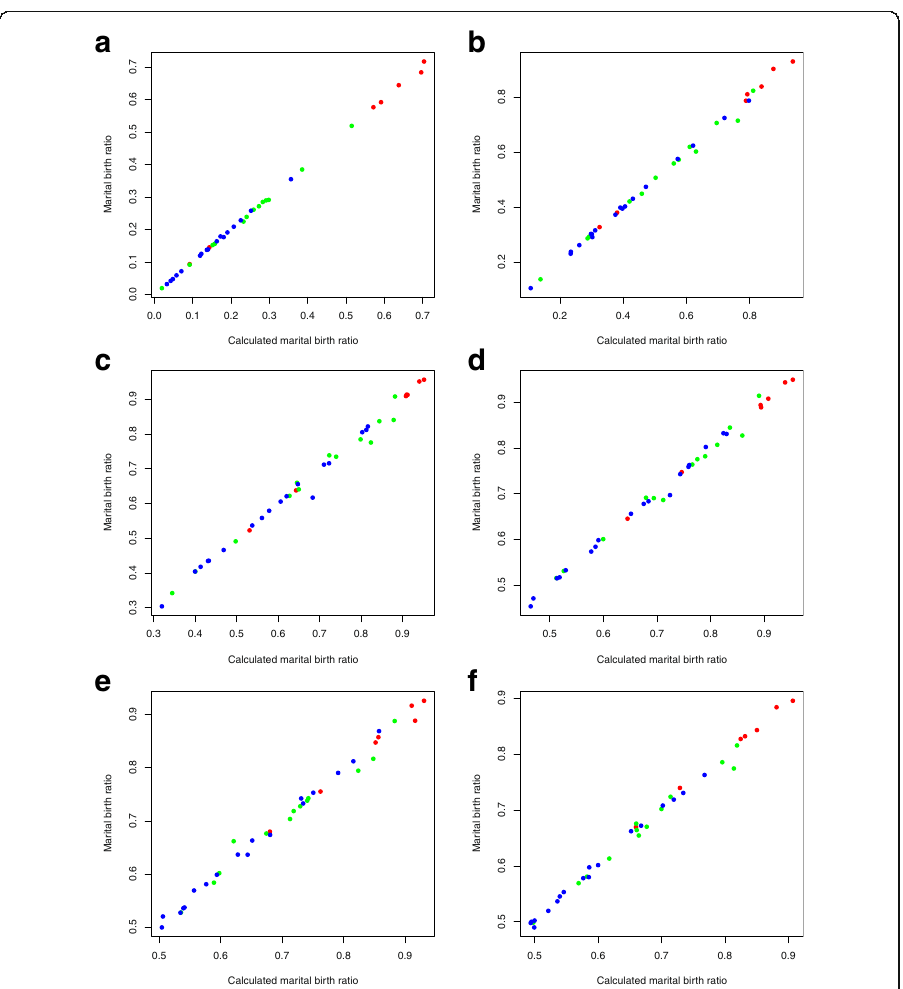
Fig. 1 The marital birth ratio, b w , from actual Eurostat data vs. the calculated marital birth ratio based off marriage and fertility data from Eurostat for the age groups of a 15 – 19, b 20 – 24, c 25 – 29, d 30 – 34, e 35 – 39, and f 40 – 44. Colors indicate data from the years of 1991 (red), 2001 (green), and 2011 (blue). All comparisons have R 2 > 0.99. Data from Eurostat (2018a, b, c, d, e, f), see details in